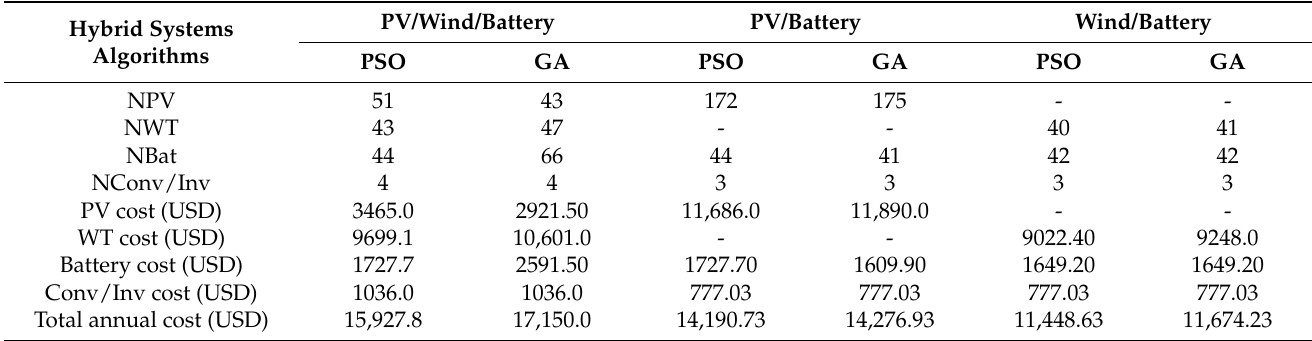
Table 4. Results of optimal sizing for Kano.